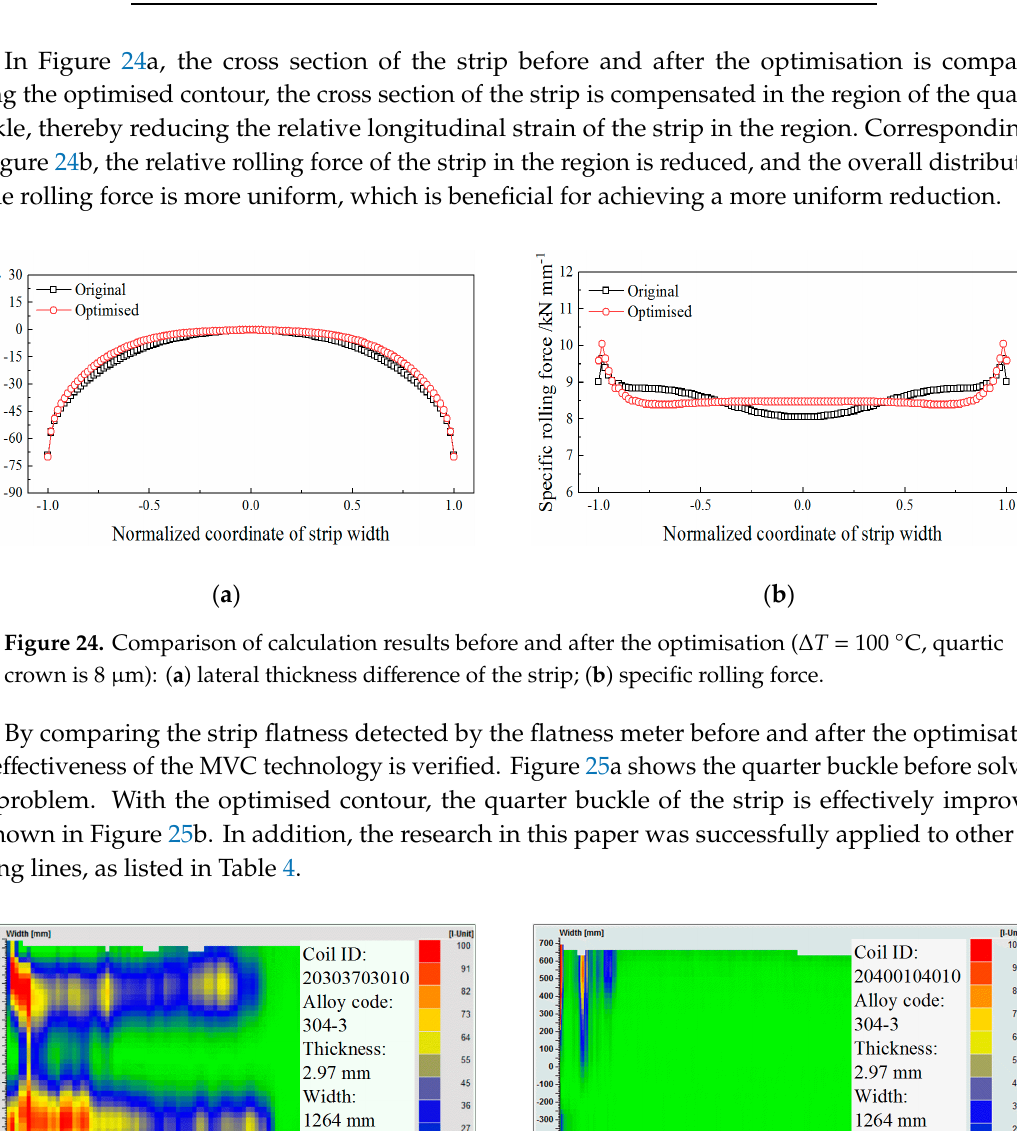
Table 4. Other hot rolling lines with a successful application.